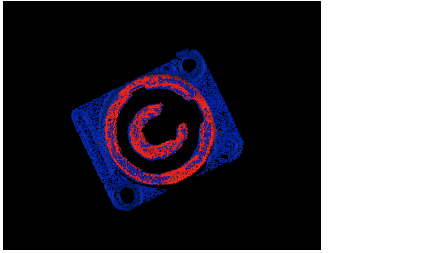
Figure 20. Automatic assembly system experiment.